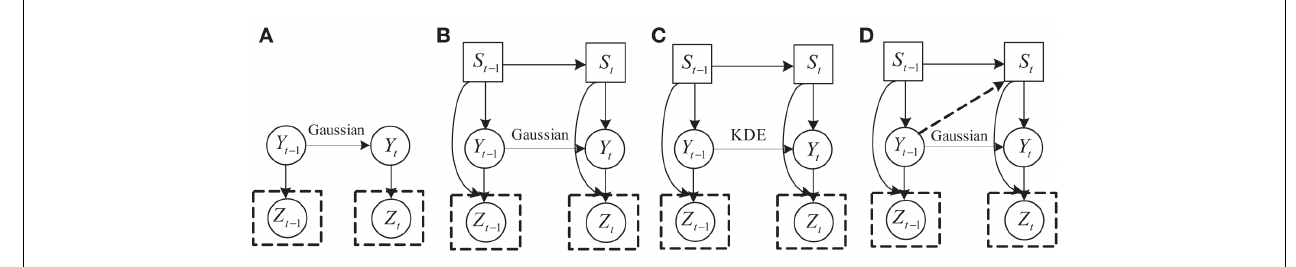
FIGURE 9 | Comparison of computational models that incorporate different types of prior knowledge. See text for details.